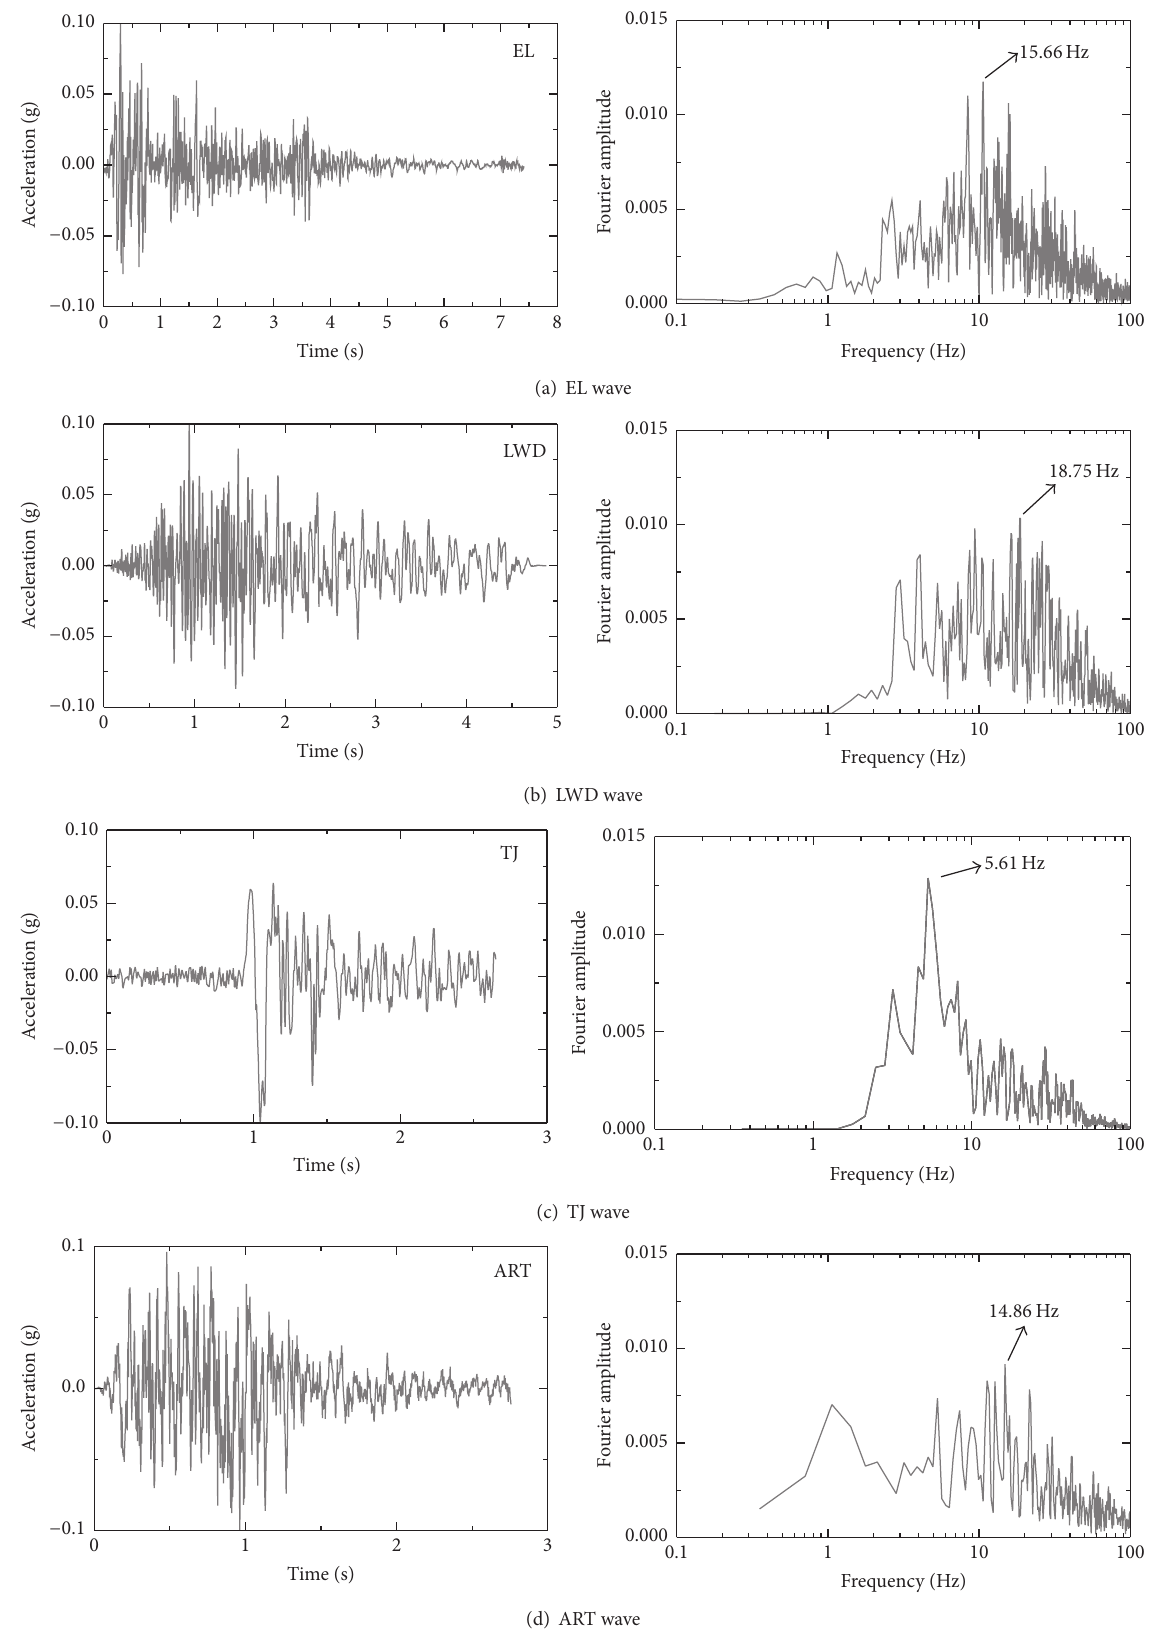
Figure 12: Time histories and Fourier amplitude spectra of input ground motion acceleration from shaking table